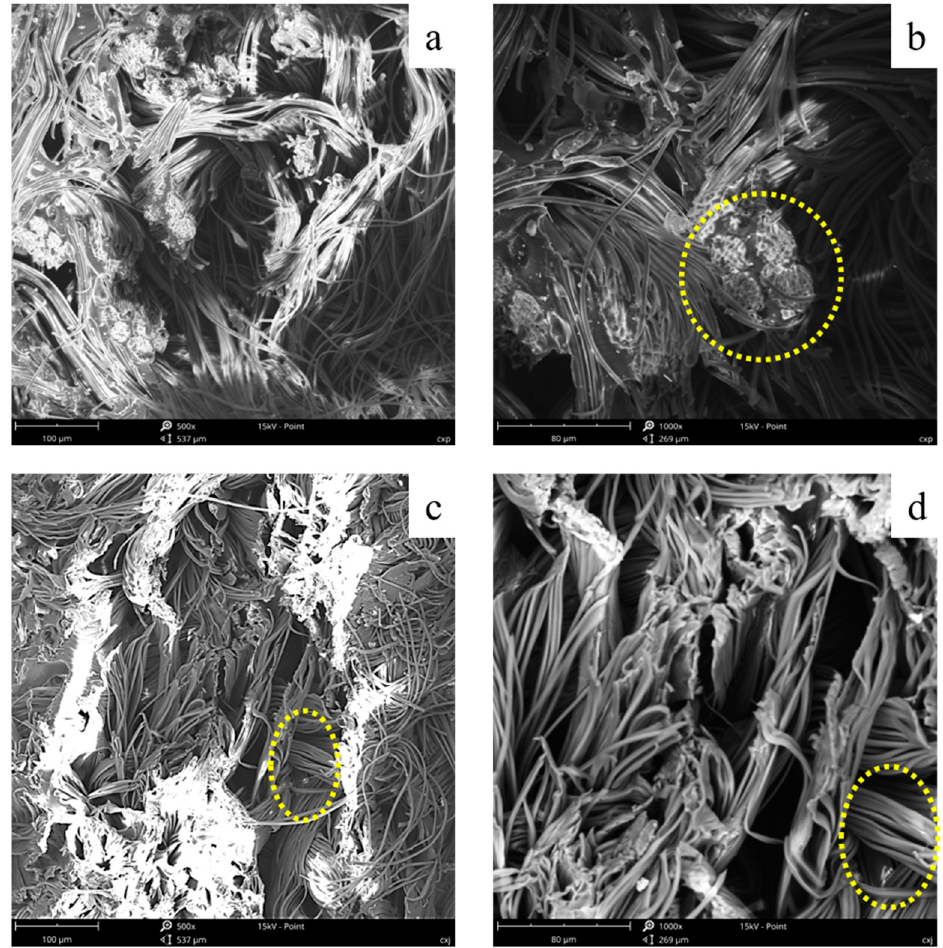
Figure 7. The structures of superfine fiber synthetic material ( a ), the surface of fixed sea ‐ island superfine fiber, ×500; ( b ), the surface of fixed sea ‐ island superfine fiber, ×1000; ( c ), the cross section of fixed sea ‐ island superfine fiber, ×500; ( d ) the cross section of fixed sea ‐ island superfine fiber, ×1000.